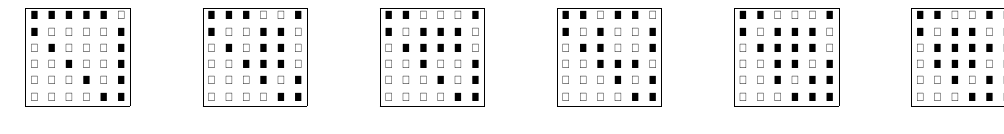
Table 18: Minimal matrix representations of all six acute 0/1 -simplices in I 6 .